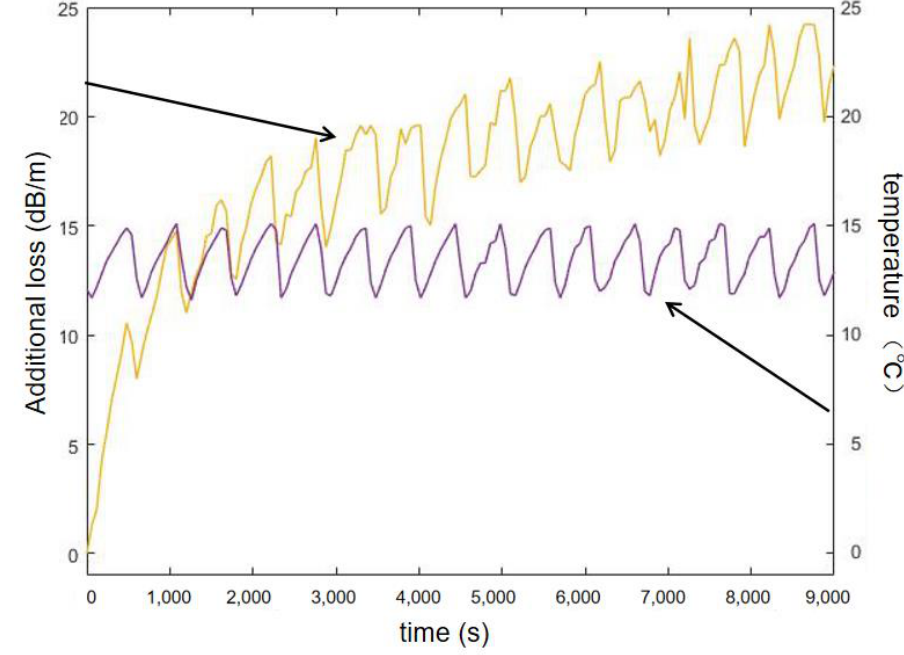
Figure 15. The curve of additional loss and water-cooling temperature with time. By measuring the transmission spectrum of the white light passing through it before and after PD, respectively, and subtracting the transmission spectrum after PD from the transmission spectrum before PD, the absorption spectrum of the sample PCF can be obtained. The results are shown in Figure 16. The absorption spectrum shows that the color center produced by the sample PCF has strong absorption in the visible range, and the highest peak is at 579.6 nm.